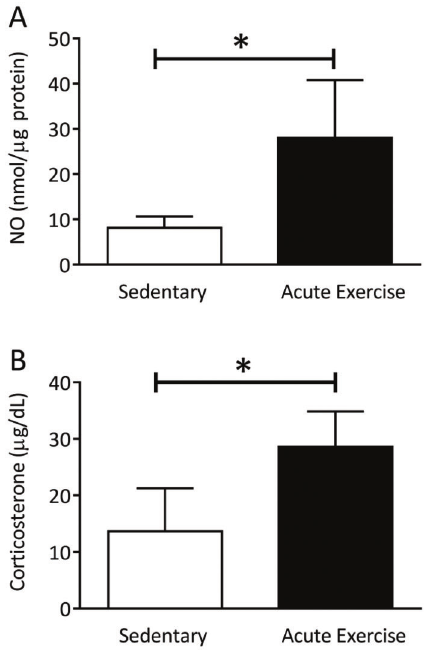
Figure 2. Comparison of plasma levels of nitric oxide ( A ) and corticosterone ( B ) in rats subjected to the sedentary or acute exercise (5%) protocols. The data are reported as means ± SD. *P o 0.05, sedentary vs 5% acute exercise (Student ’ s t -test).